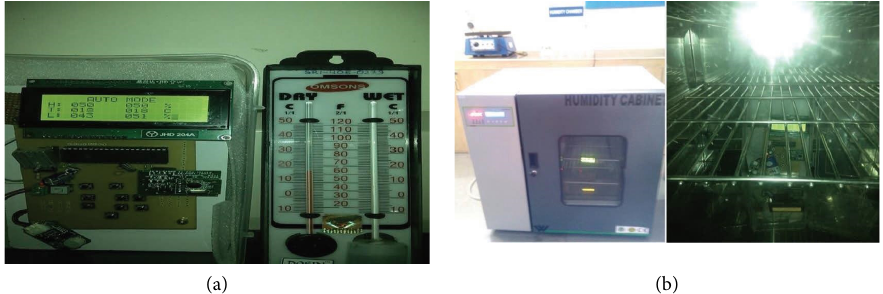
Figure 11: (a) Testing of a temperature sensor with a standard thermometer. (b) Testing of humidity sensor with a standard